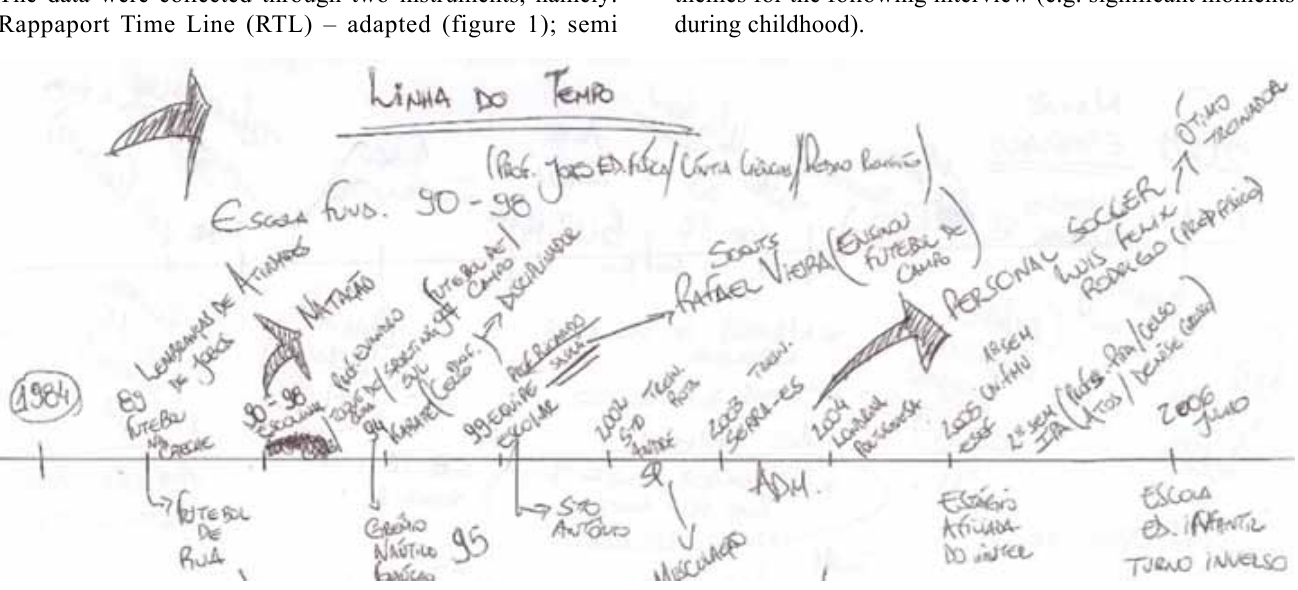
Figure 1 A section from C4 Rappaport Time